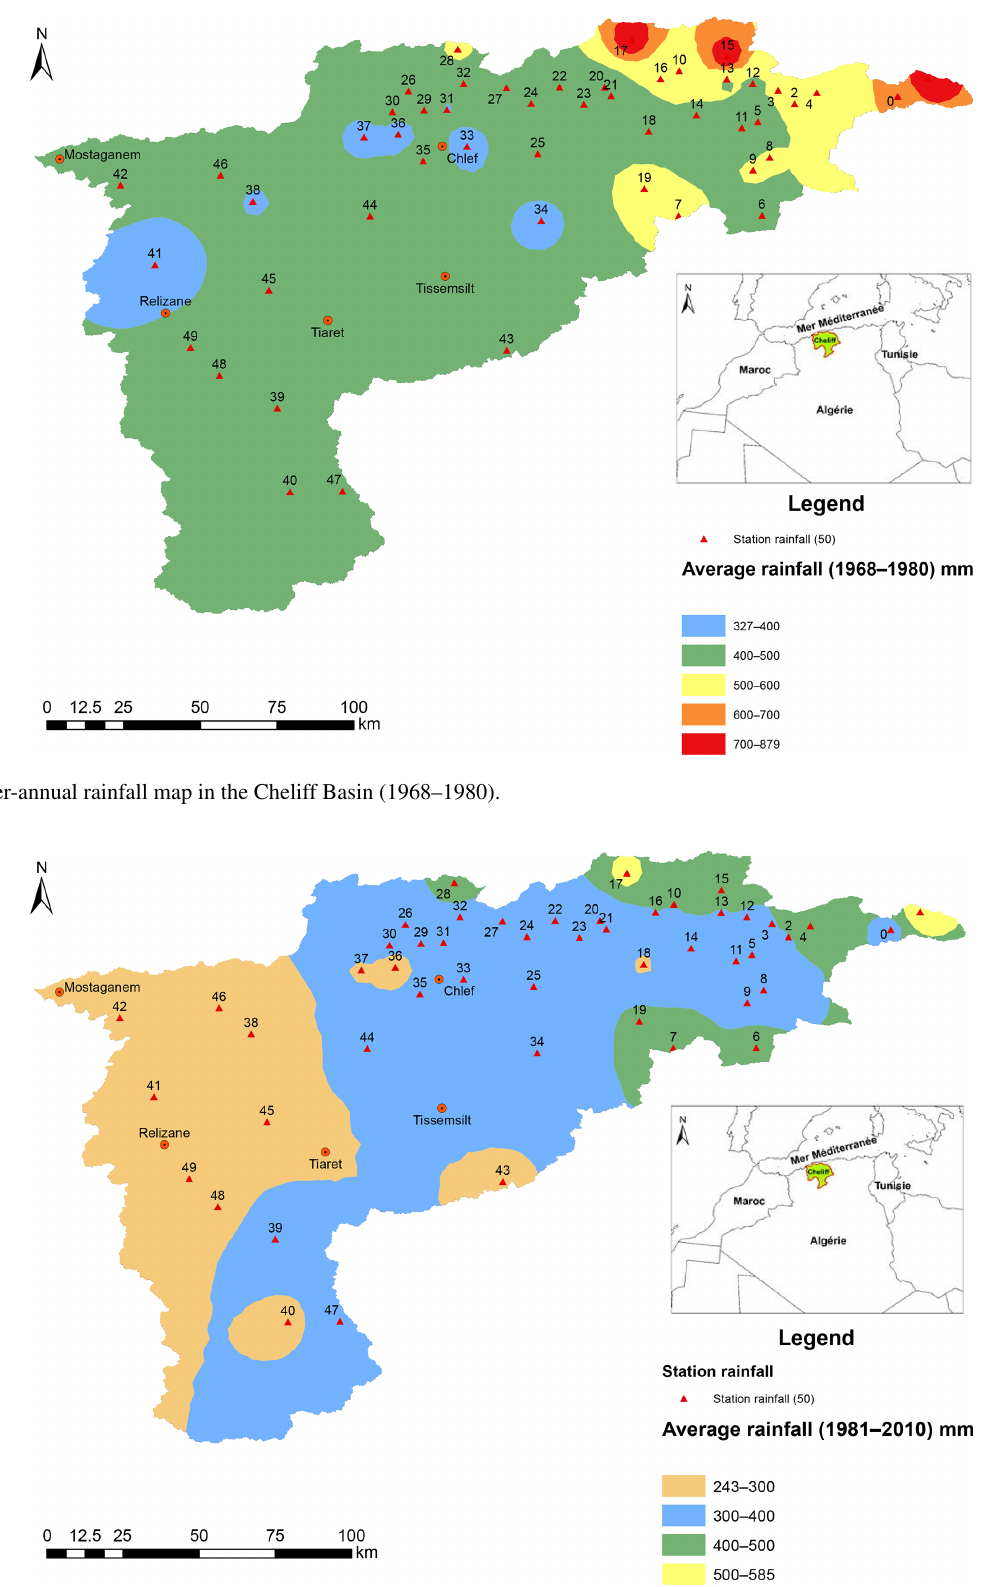
Figure 6. Inter-annual rainfall map in the Cheliff Basin